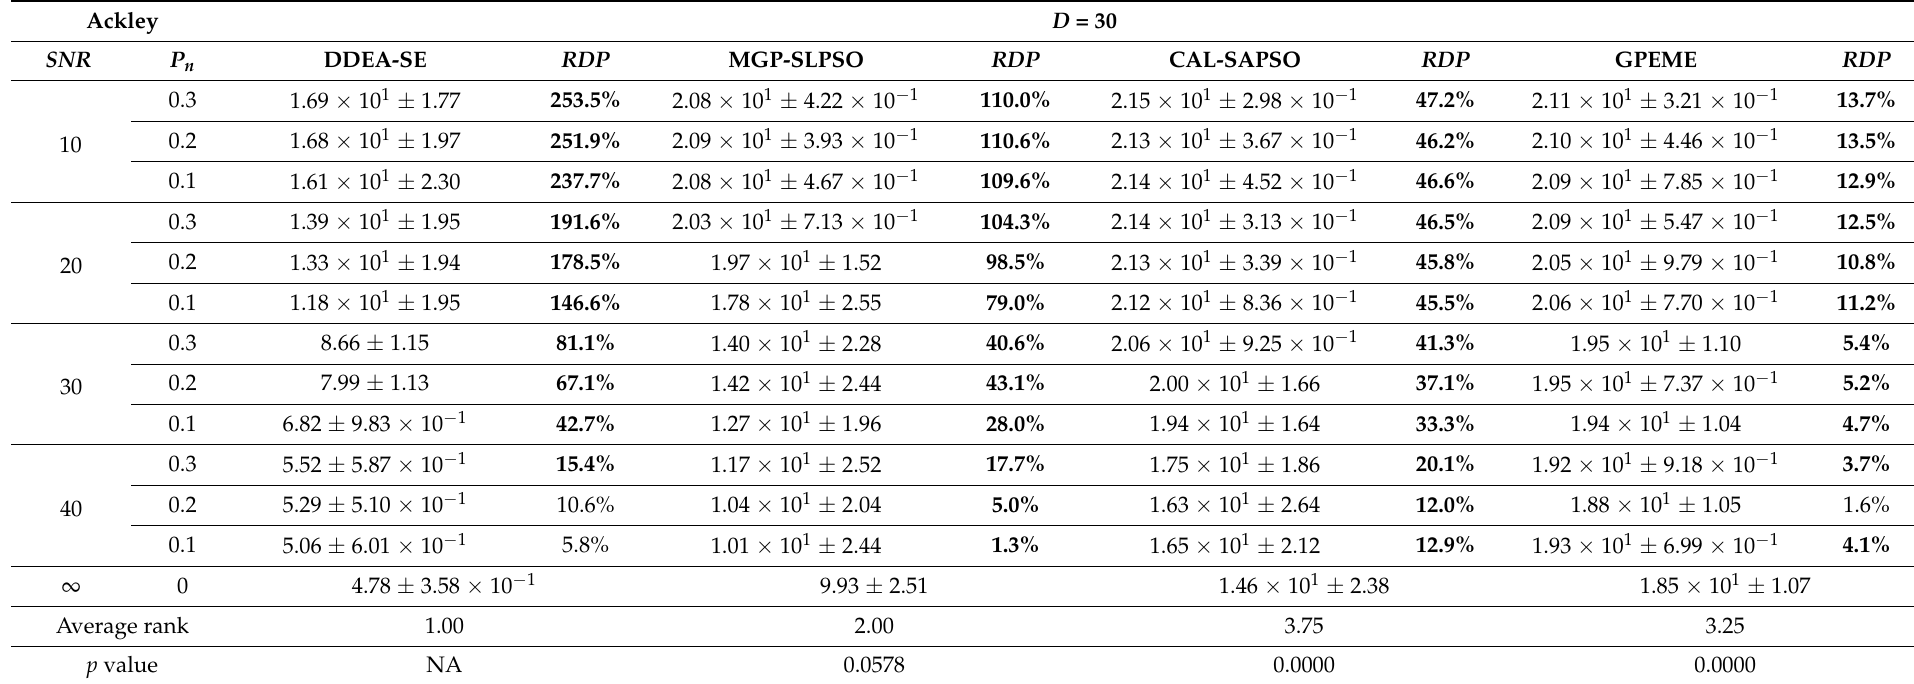
Table A6. Experimental results (with standard deviation) and RDP of DDEAs on 30-dimensional Ackley